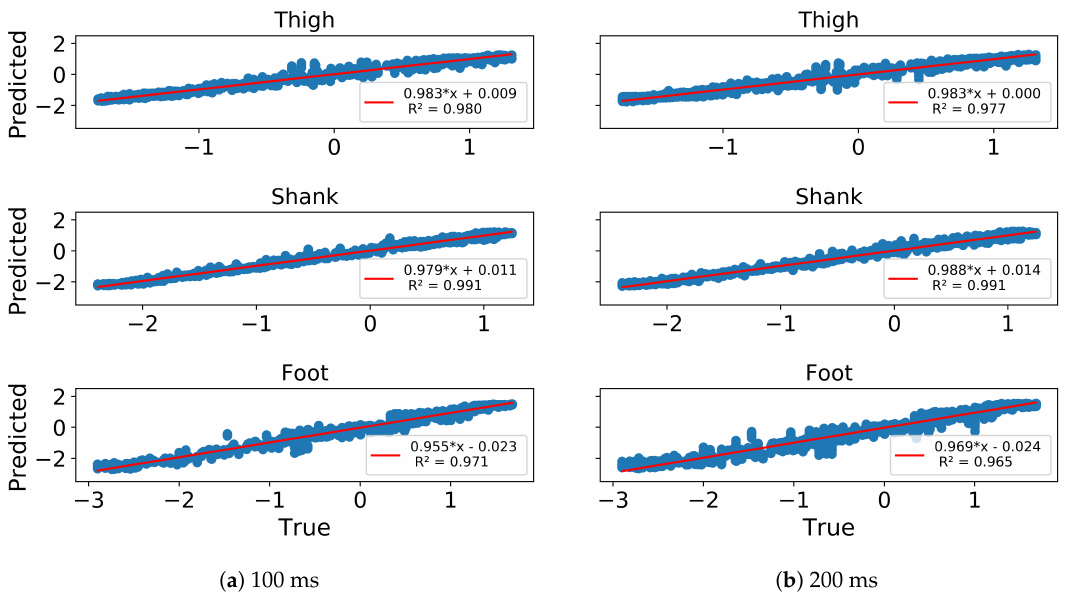
Figure 6. Linear correlation of Predicted ( y -axis) vs. True ( x -axis) z-score normalized angular velocities of ipsilateral thigh, shank and foot of a representative subject in 100 ms ( a ) and 200 ms ( b ) ahead prediction. All angular velocity values shown are normalized to have zero mean and unit variance.